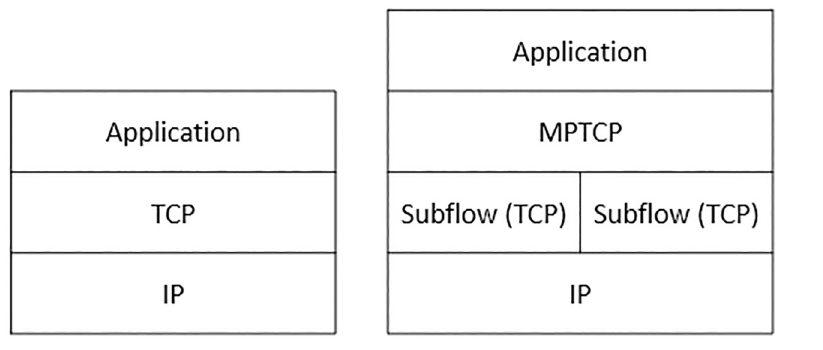
Fig 2. Standard TCP and MPTCP protocol stacks.